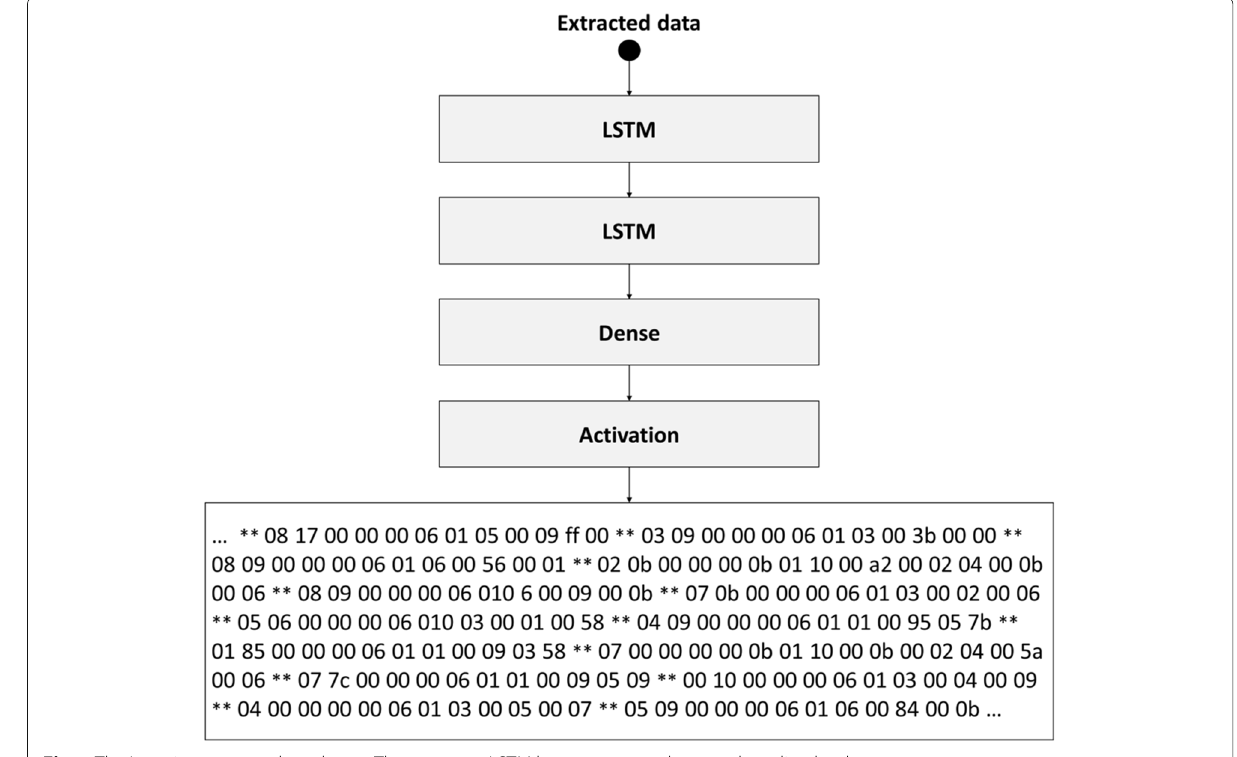
Fig. 4 The Learning process about layers. There are two LSTM layers we use to learn and predict the data